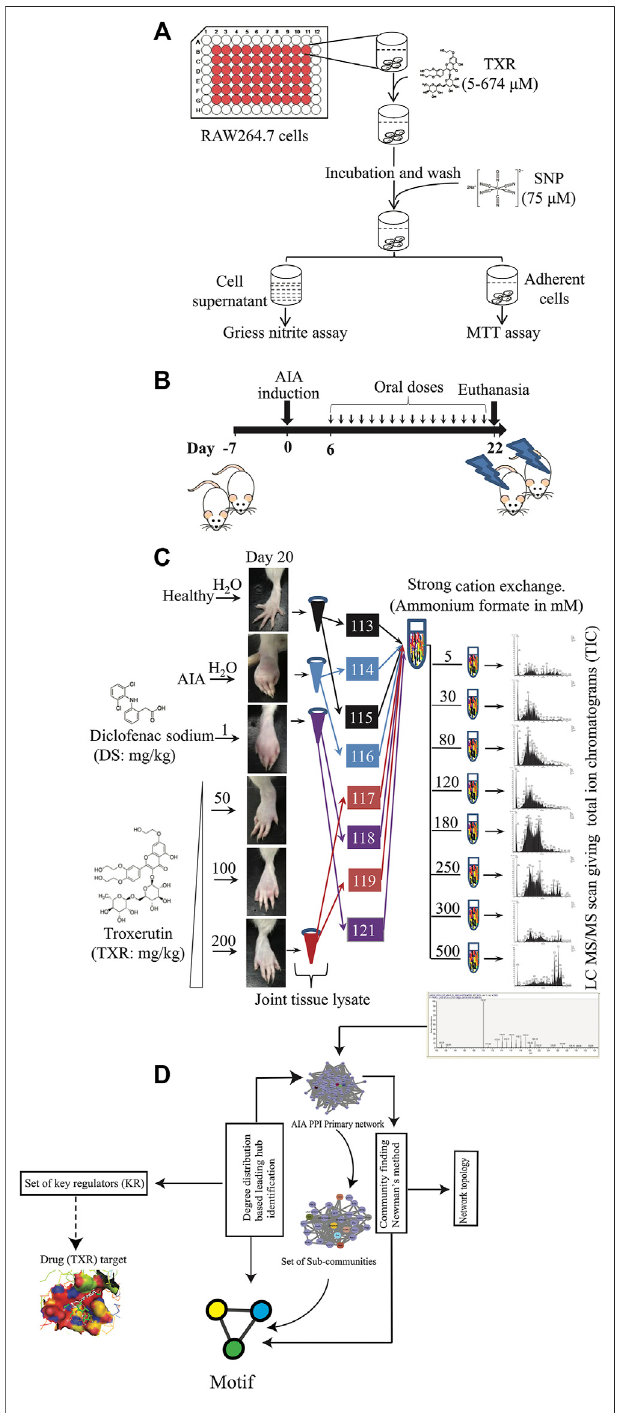
FIGURE 1 | Schematic representation of the experimental approach used in this study. (A) Nitric oxide inhibition assay simultaneously with the cytotoxicity of TXR was evaluated using RAW264.7 cells. (B) Induction of adjuvant-induced arthritis (AIA) and the treatment plan. (C) Joint homogenates from multiple study groups were used for proteomics experiments. (D) Informatics analyses were used for identifying the key regulator